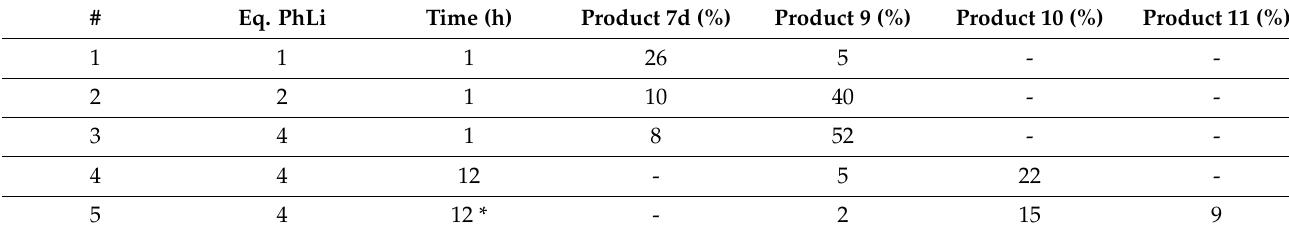
Table 5. Reaction conditions and yields of compounds 7d , 9–11 .